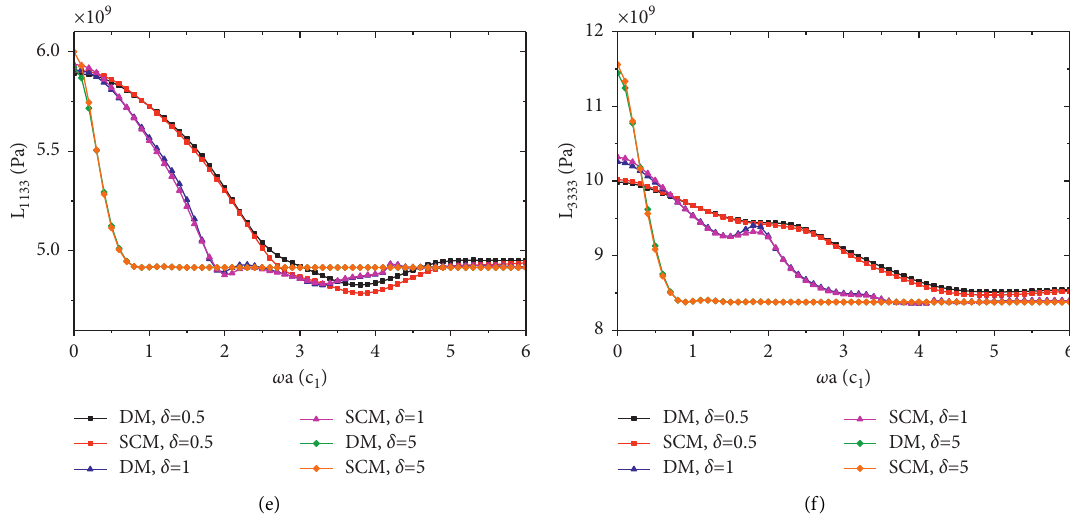
Figure 10: When quasi-P wave propagates in the composite material for inclusion volume fraction of 15.9% and δ � 0 . 5, 1, and 5, the dynamic effective density ρ (DM) and self-consistent method (SCM),